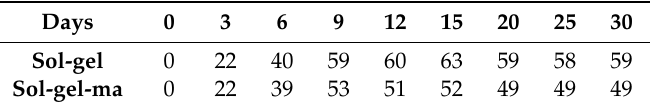
Table 3. Biodegradation rate (%) of bio-based films produced by the sol-gel and sol-gel-ma methods, containing 1.56 w / w % maleic